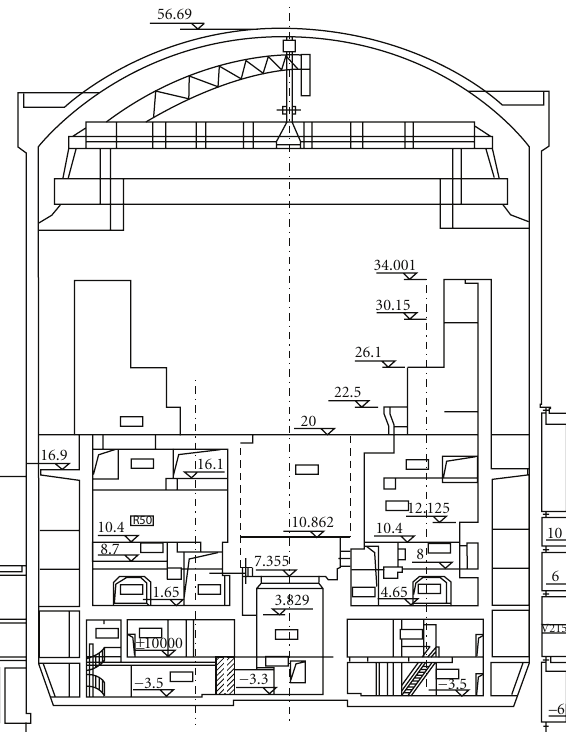
Figure 1: Vertical view of Qinshan-II containment geometry.